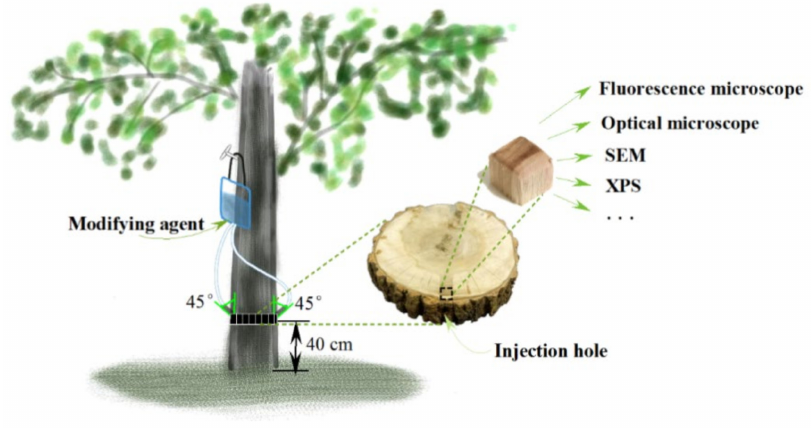
Figure 1. Schematic diagram of poplar living tree